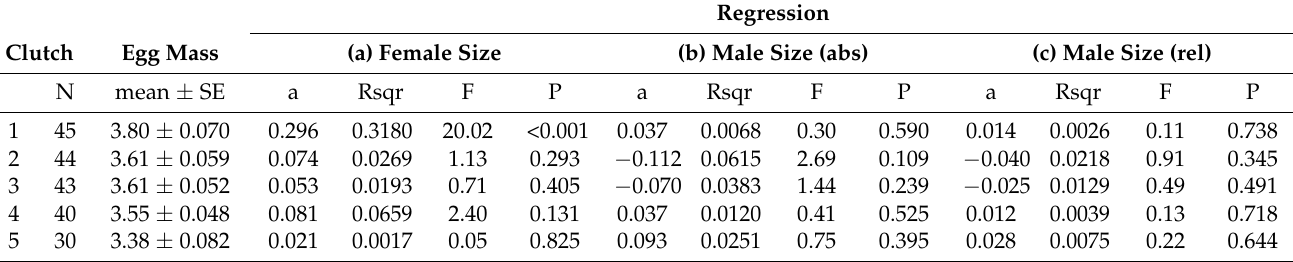
Table 3. Relationship between body size and egg mass in the first five clutches laid after the start of the oviposition, experiment of 2022. Clutch: clutch order, N: number of clutches. Egg mass: weight of one egg (g*10,000). Regression: (a) Female size: regression of egg mass on female body length (mm). (b) Male size (abs): regression of residuals of regression (a) on “absolute male size” which is male body length (mm). (c) Male size (rel): regression of residuals of regression (a) on “relative male size” which is the difference between the male and female body length (mm). a: slope of regression line, Rsqr: coefficient of determination of regression line, F: F statistics of ANOVA test, P: P value of ANOVA test.